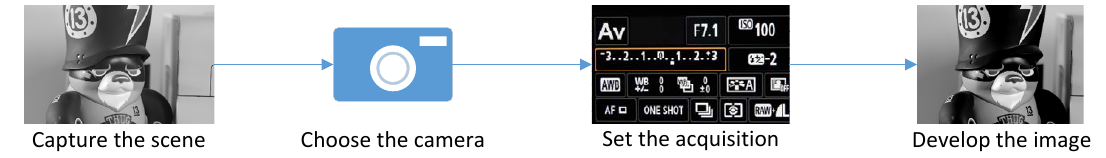
Figure 1. The general procedure of a RAW